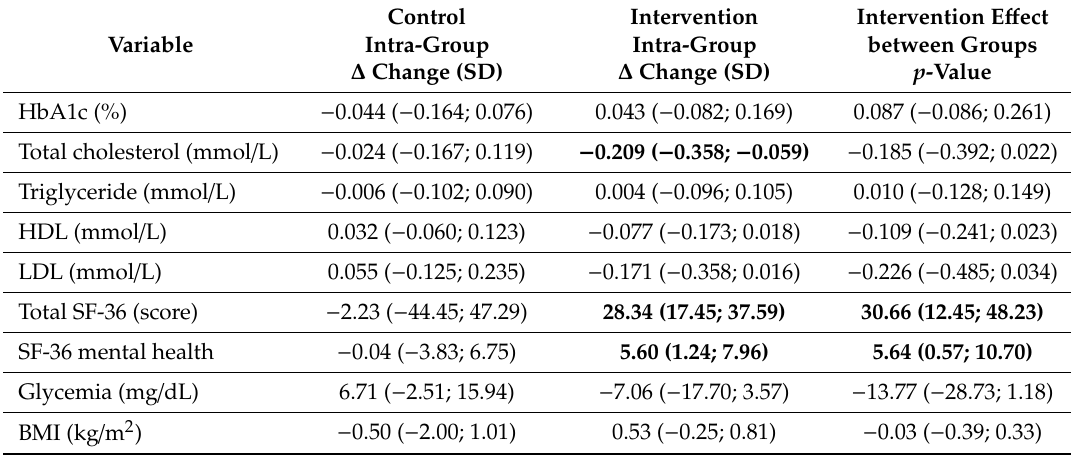
Table 2. Within-group mean changes from baseline (from day zero to the end of the intervention) for clinical markers.